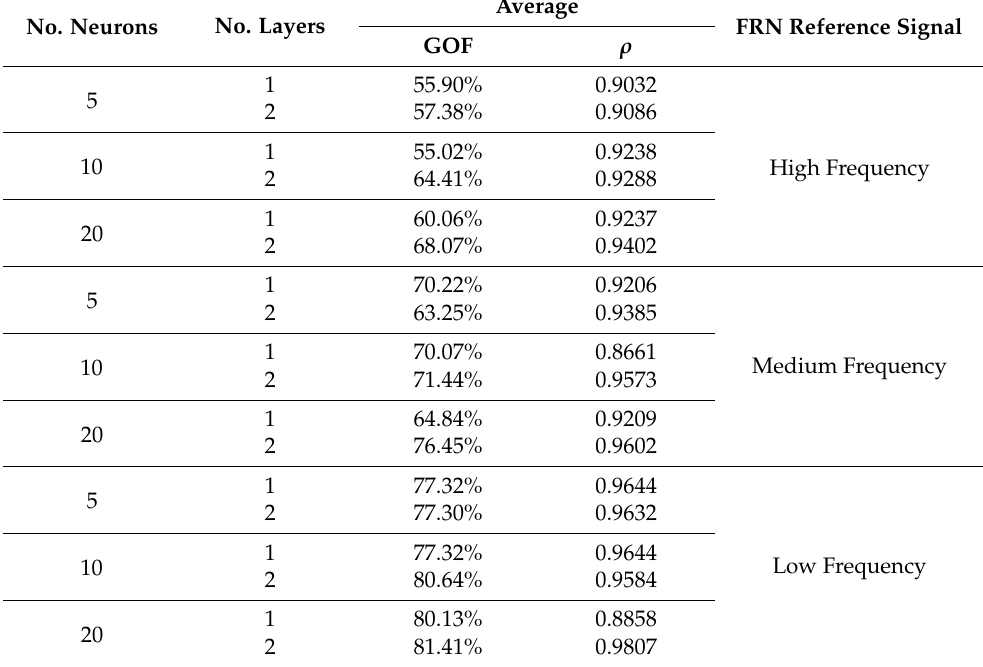
Table 1. Results (GOF and ρ ) for NARXNN trained with acquired data for a different number of neurons and hidden layers.